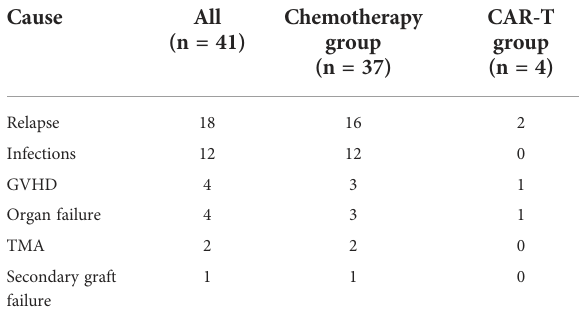
TABLE 2 Causes of death.